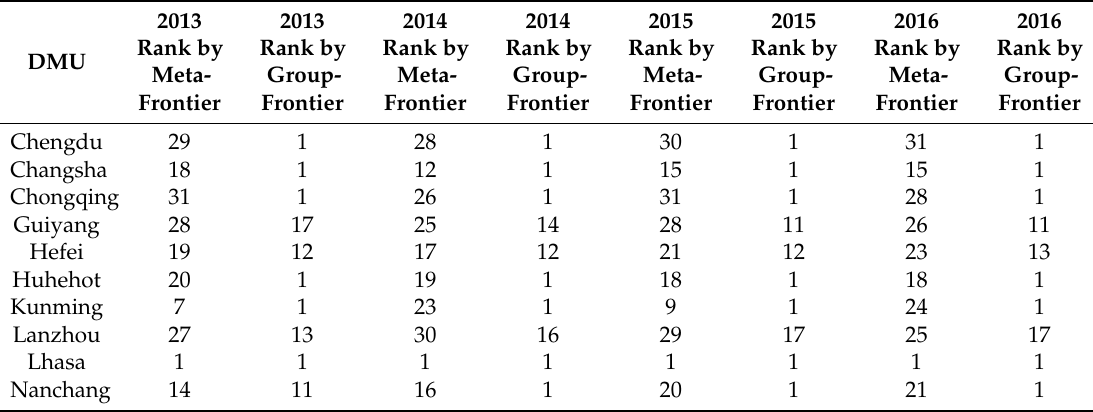
Table 4. Comparison of the meta frontier and group frontier city rankings